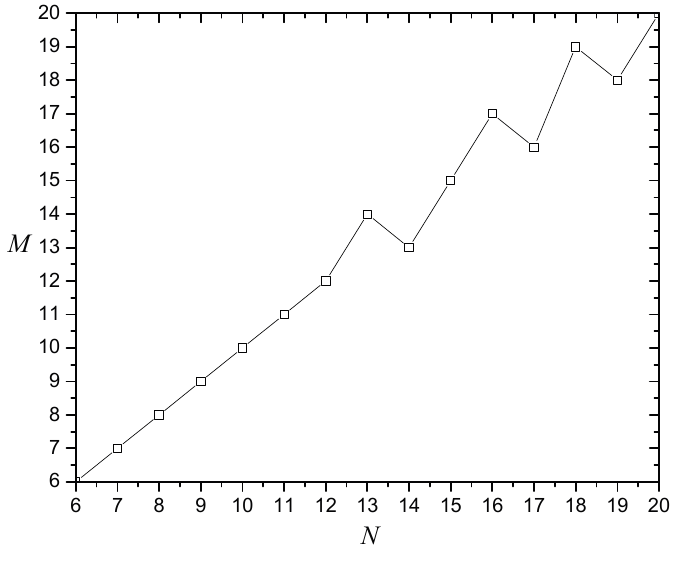
Figure 3. Network lifetime versus different values of α with r 0